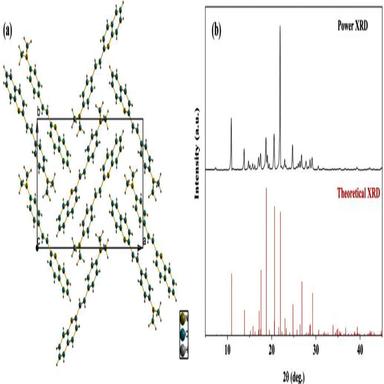
(a) Crystal packing diagram of DADMQ. (b) Powder XRD and Theoretical patterns of DADMQ crystal.